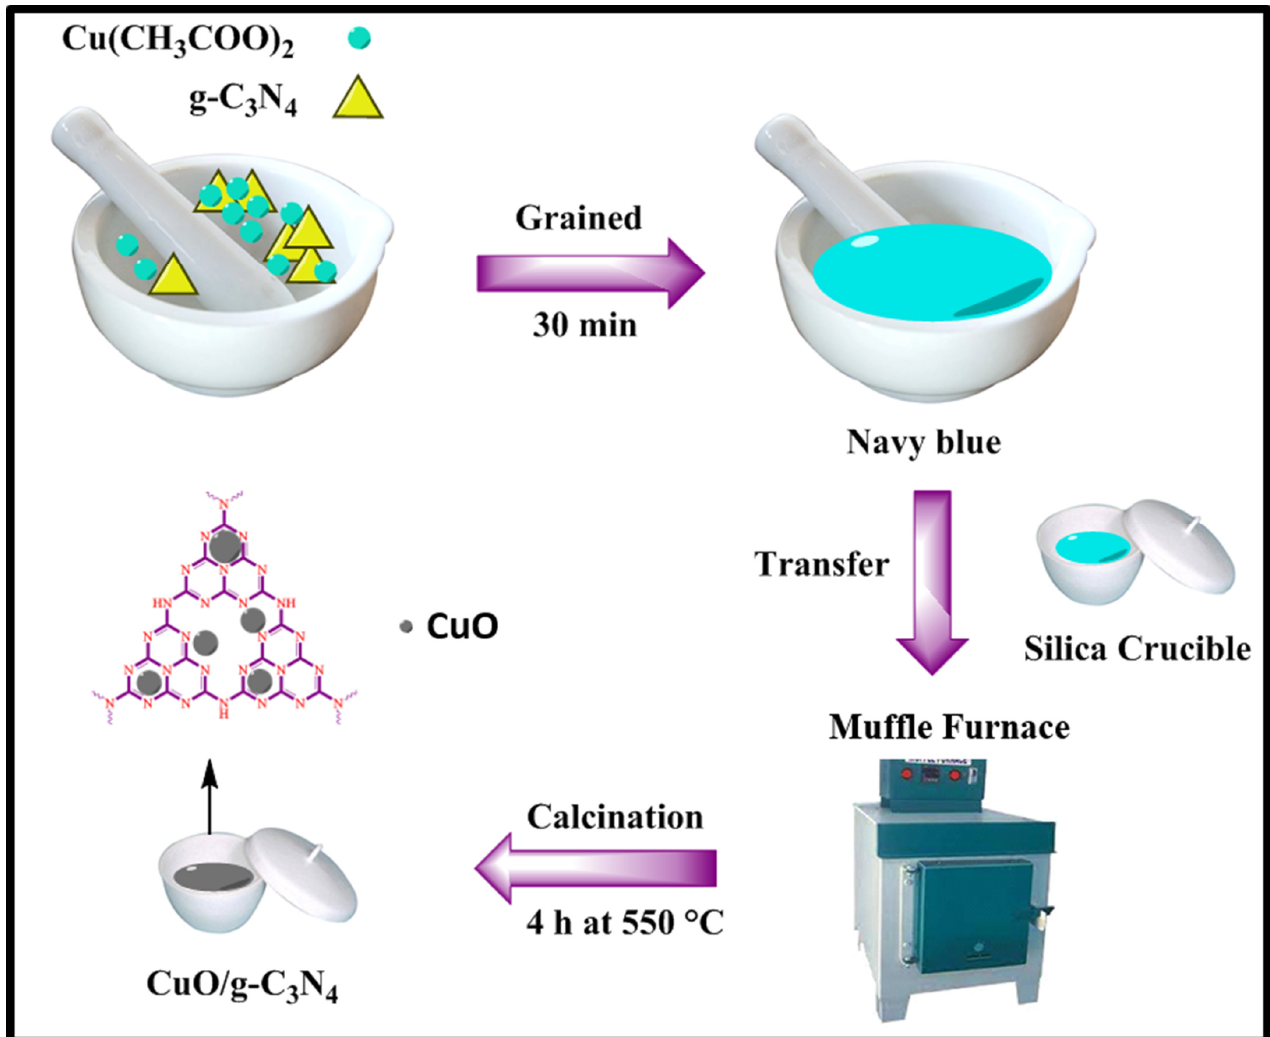
Figure 2. CuO/g-C 3 N 4 nanocomposites prepared by dry synthesis method.